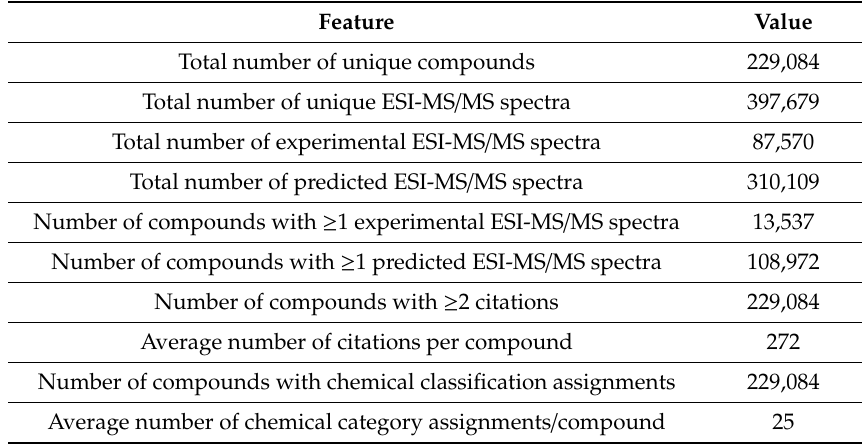
Table 2. Statistics for the Competitive Fragmentation Modeling-ID (CFM-ID) 3.0 spectral